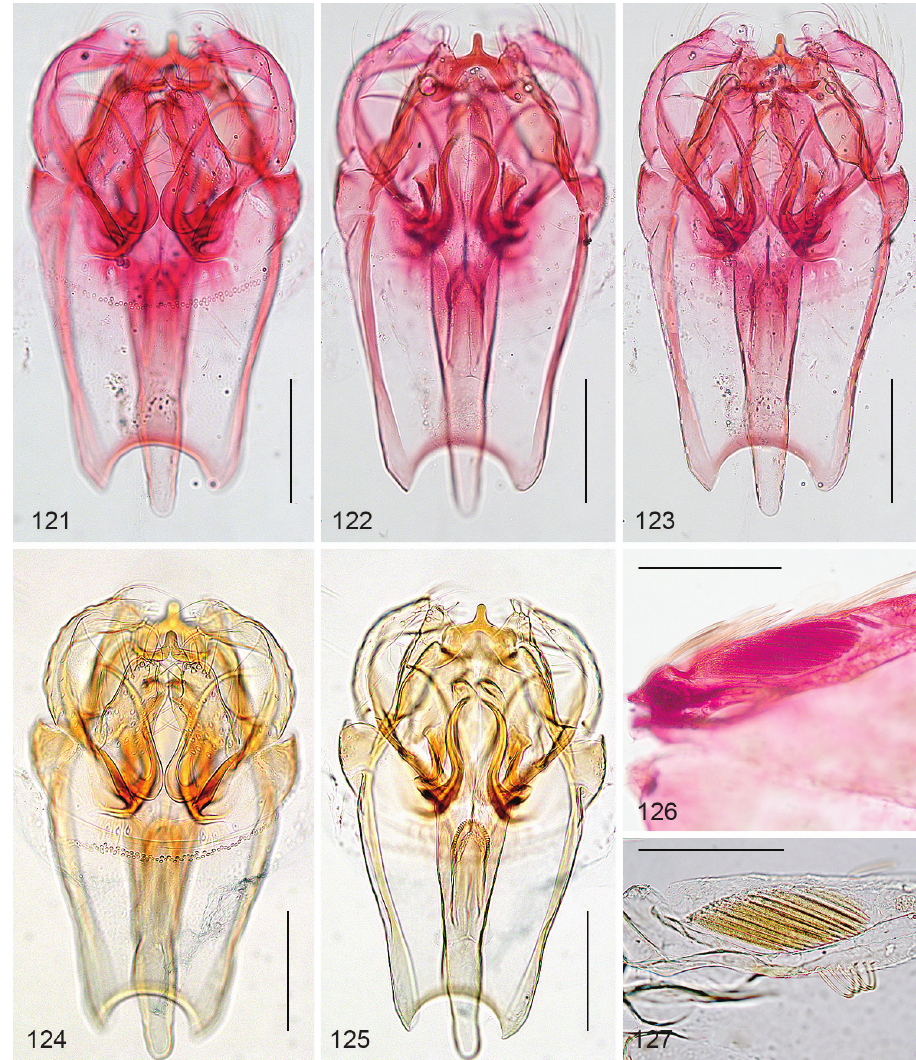
Figures 121–127. Hesperolyra diskusi , paratypes, male genitalia and forewing fold. 121–123 slide EvN4501 124–125 slide BM29130 126–127 Forewing fold and costal retinaculum, showing special scales hidden under fold, stained slide EvN4501, unstained, slide BM28847. Scale bars: 100 µm. Male genitalia (Figs 121–125, 128) (n=3). Total length capsule ca 330–350